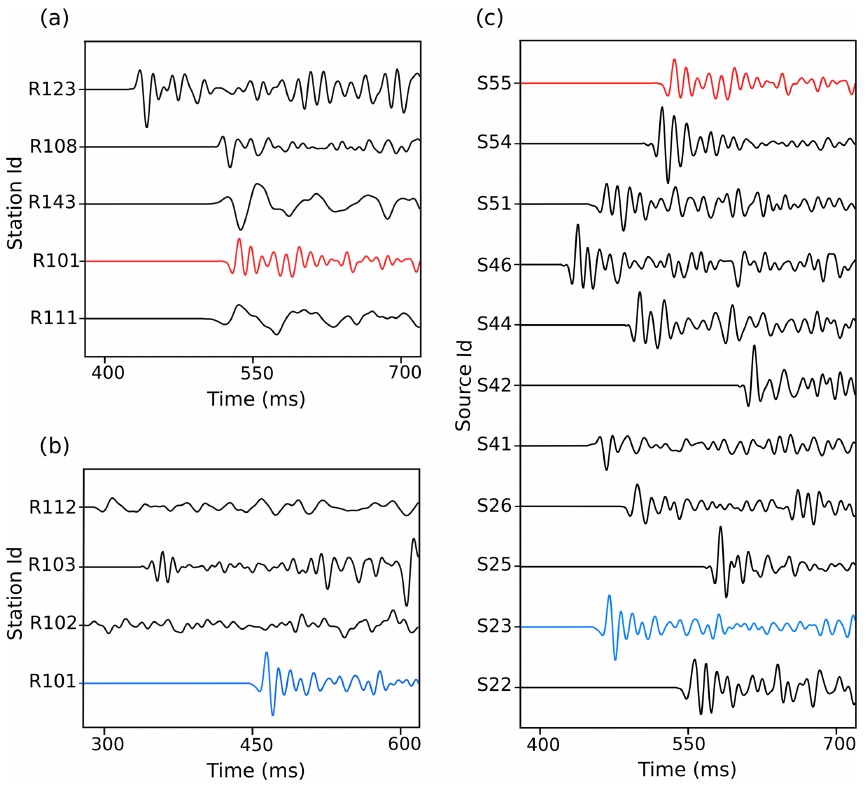
Figure 4. A comparison between common-source gathers S55 and S23 (a, b) (same events, different receivers) and a common-receiver gather R101 (c) (same receiver, different events). R101 is marked in red and blue for events S55 and S23,